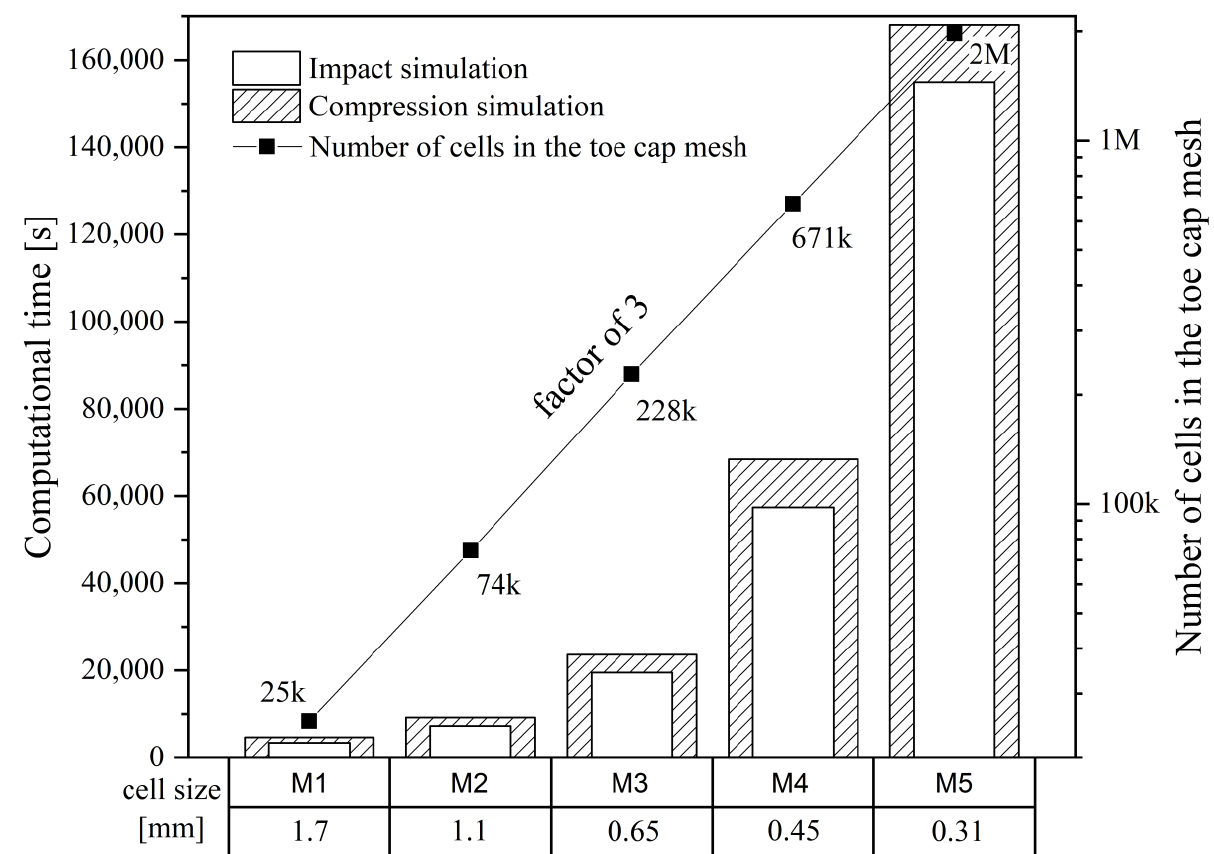
Figure 8. Details of the mesh study for both mechanical